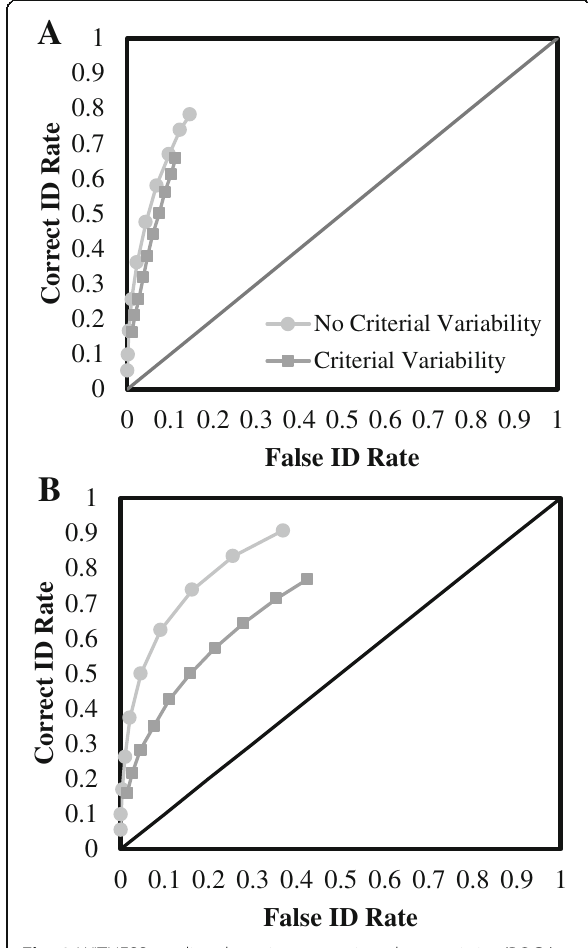
Fig. 8 WITNESS-predicted receiver operating characteristics (ROCs) with and without criterial variability for: a simultaneous lineups, b and showups. Parameters for the no criterial variability condition were: a = .35, SSF = SSP = .5, csim = csu = .07. Parameter for the criterial variability condition were the same except that csim = csu ~ N( μ = .07, = .75 * μ ). SSP Similarity of the innocent Suspect to the PERP, SSF Similarity of the Suspect to the Fillers, PERP